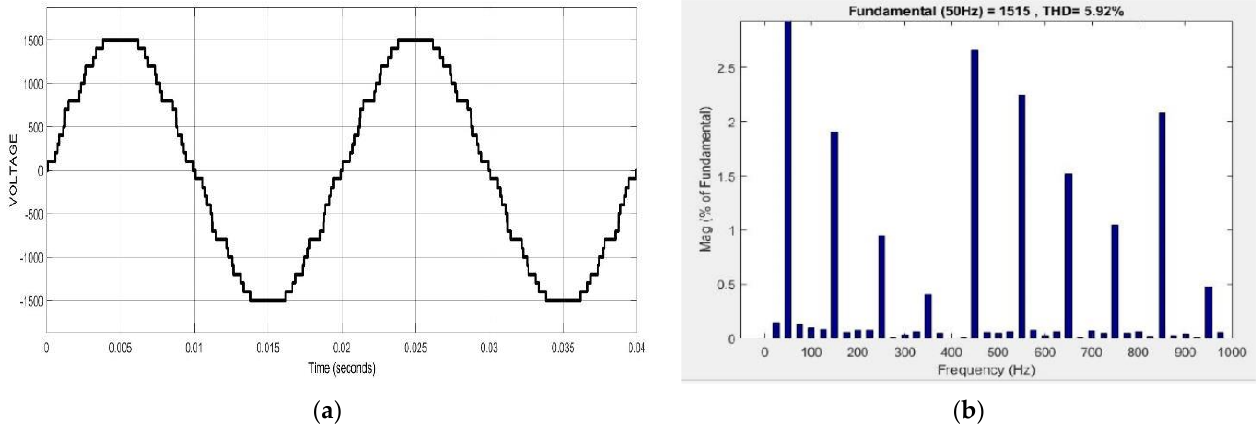
Figure 31. In this figure, ( a ) represents PSO waveform and ( b ) represents the THD spectrum of PSO. Table 9. Comparison of THD values of LF-IGWO with other techniques. Algorithm LF-IGWO